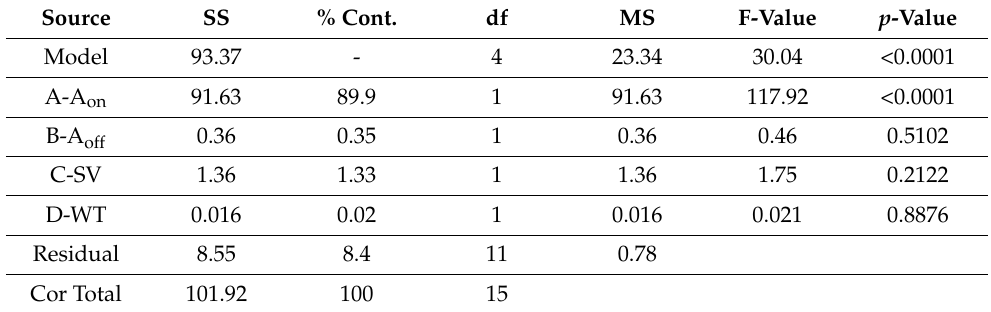
Table 7. ANOVA for Rz.